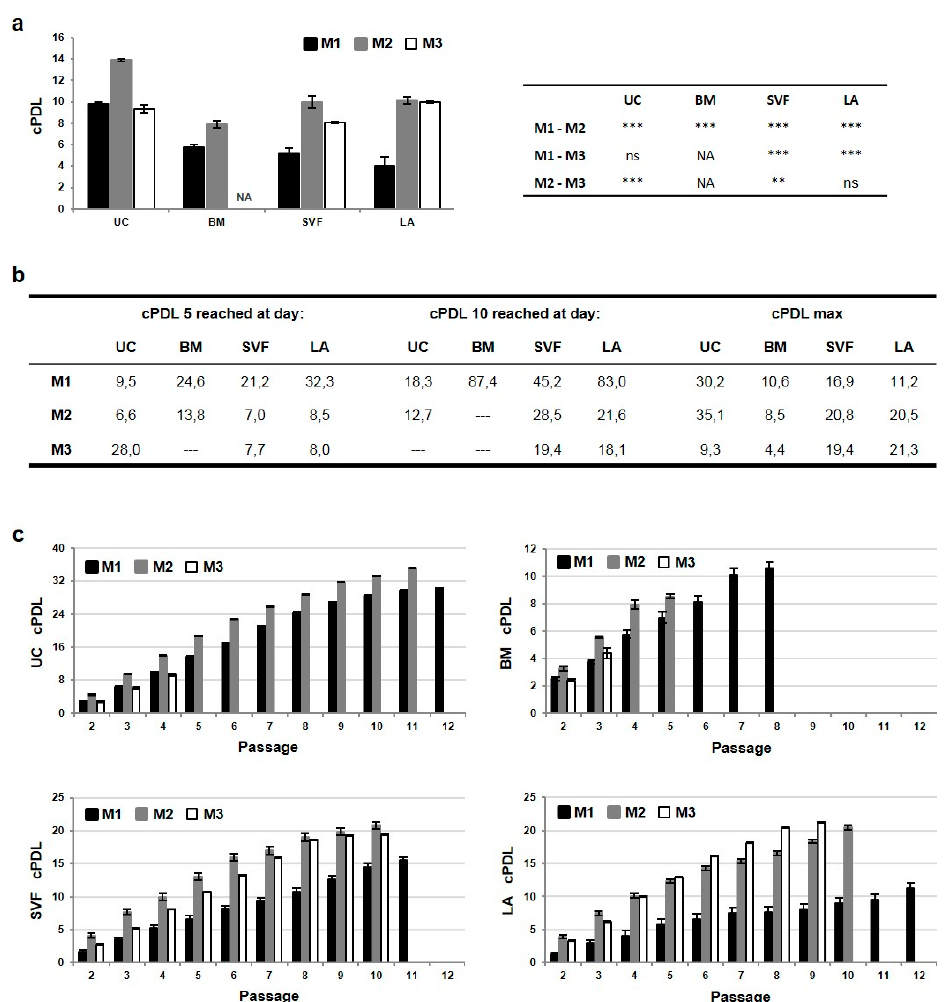
Figure 4. cPDL of tissue-specific MSCs. ( a ) cPDL of MSC lines expanded in M1, M2 and M3 media